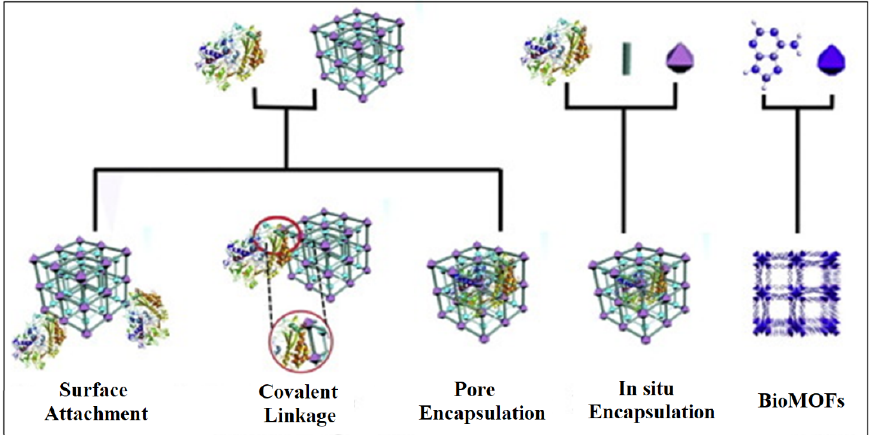
Figure 5. Various approaches of drug encapsulation/binding/within/onto MOF nanostructures. Reproduced with permission from Ref. [148]. Copyright © 2019, Elsevier.